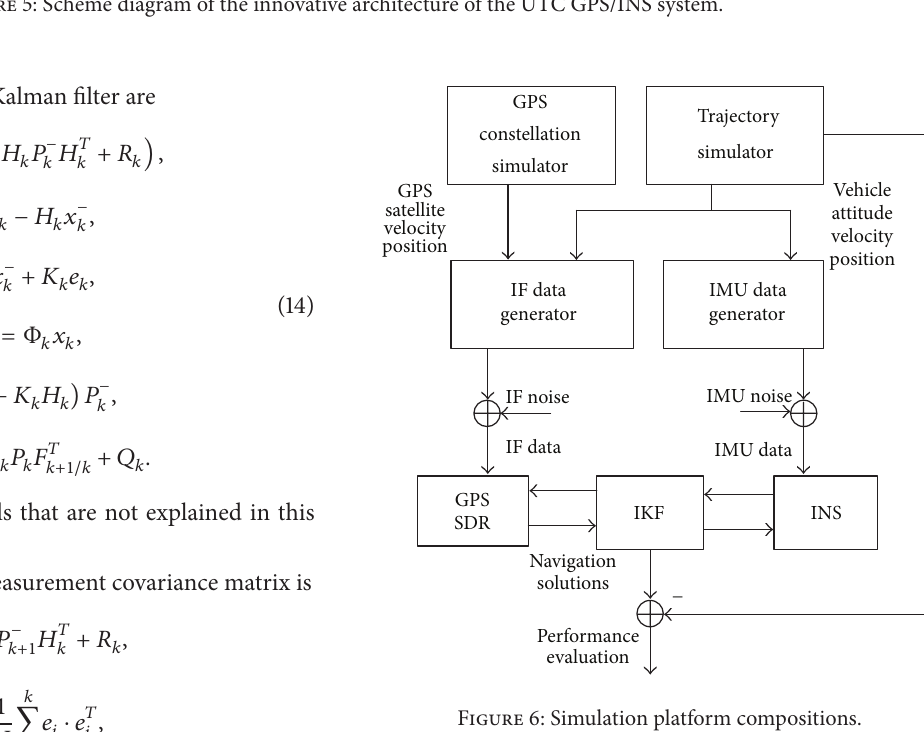
Figure 5: Scheme diagram of the innovative architecture of the UTC GPS/INS system.